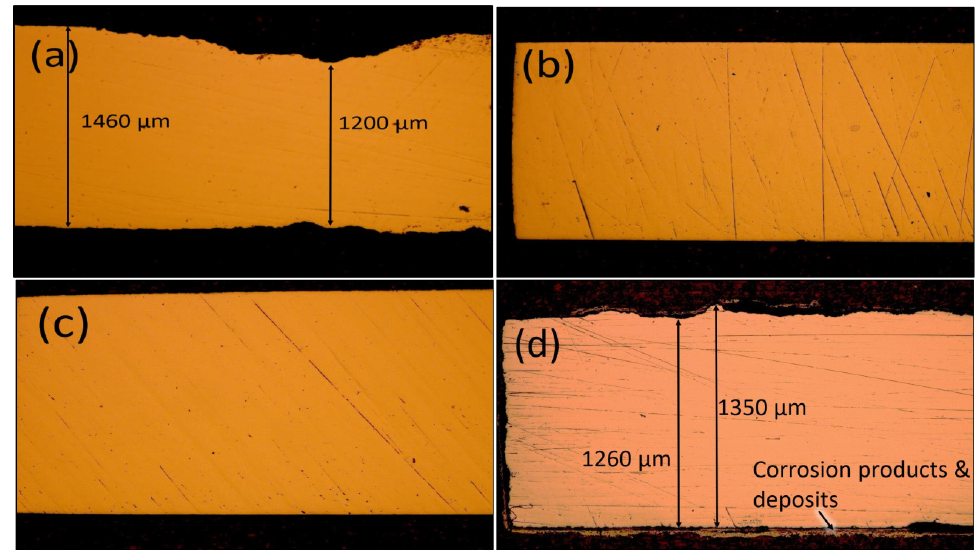
Figure 4. Optical microscope (5× magnification) of a carbon-steel sample cross-section ( a ) 1 cm from the inlet end of sample 1, ( b ) 3 cm from the inlet end of sample 1 in the first reactor, ( c ) In the middle of sample 5 in the second reactor and ( d ) one cm from the outlet end of sample 9 in the third reactor.